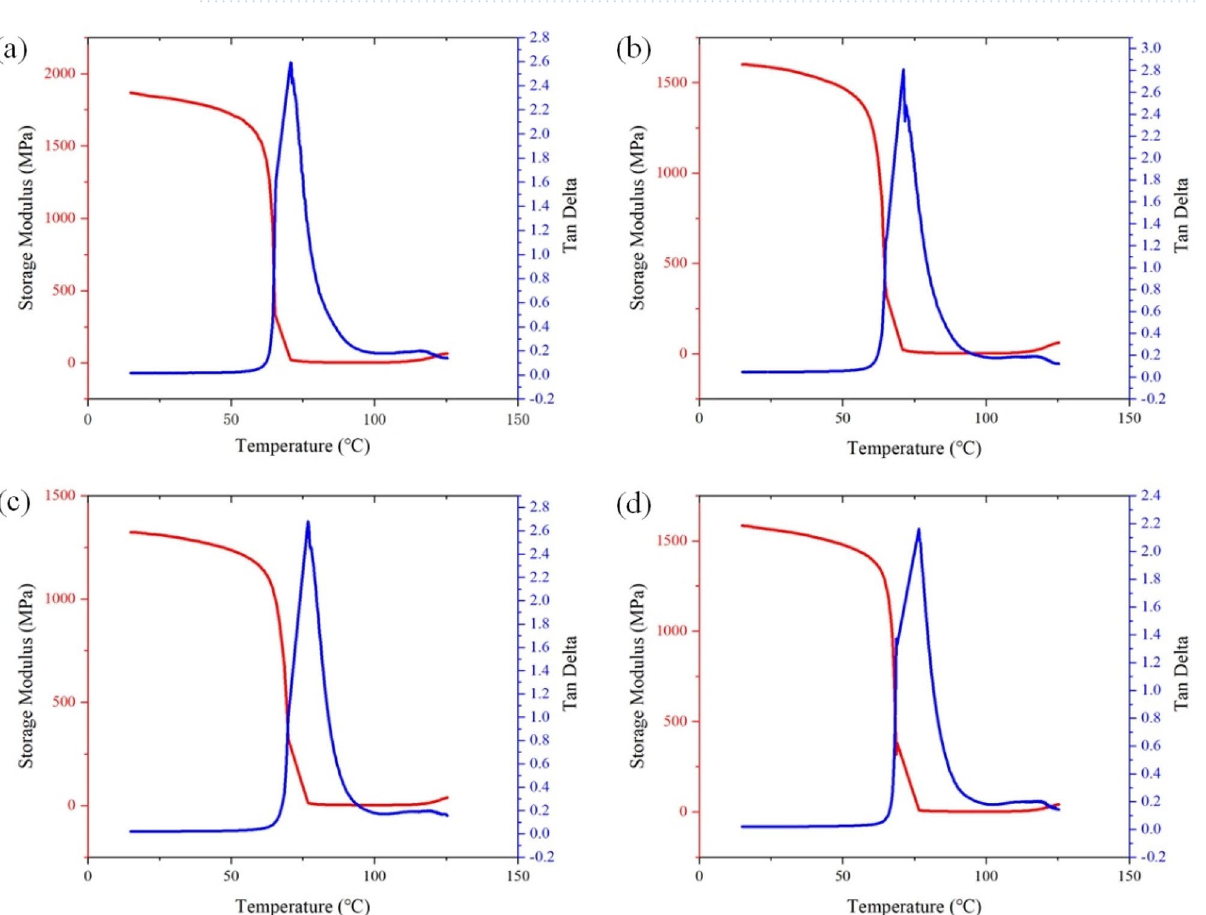
Figure 5. ( a ) 195 °C printing temperature energy storage and Tan Delta; ( b )200 °C energy storage and Tan Delta; ( c ) 205 °C printing temperature energy storage and Tan Delta; and ( d ) 210 °C printing temperature energy storage and Tan